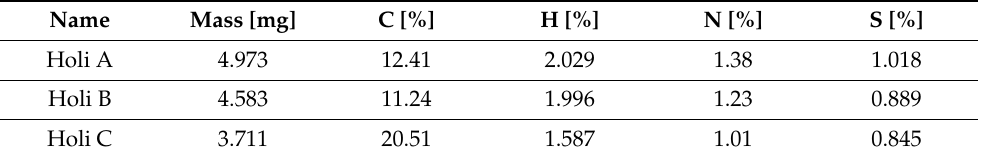
Table 2. Chemical composition of Holi powders.